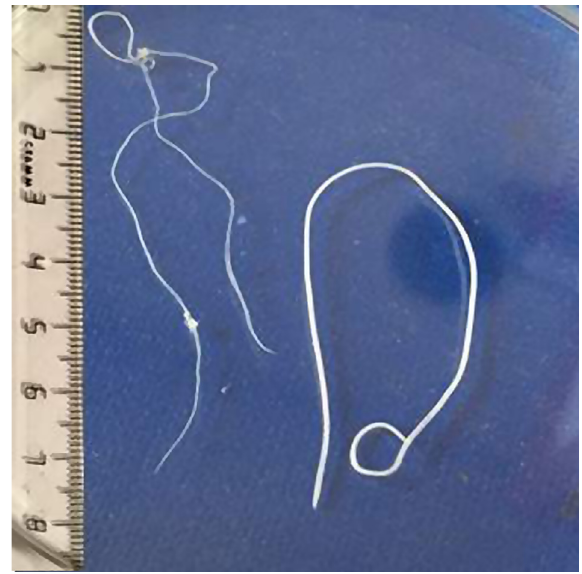
Figure 1. Immature female worm of Dirofilaria immitis (left) isolated from the scrotum of a child living near Moscow, present case, and an immature female worm of Dirofilaria repens (right) isolated from another patient in Russia, for